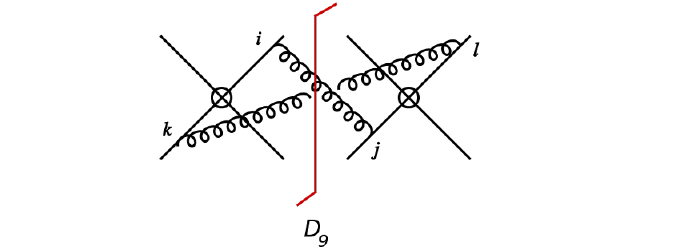
Figure 8 . Four-Wilson-line, double cut diagram required in the calculation of the NNLO soft